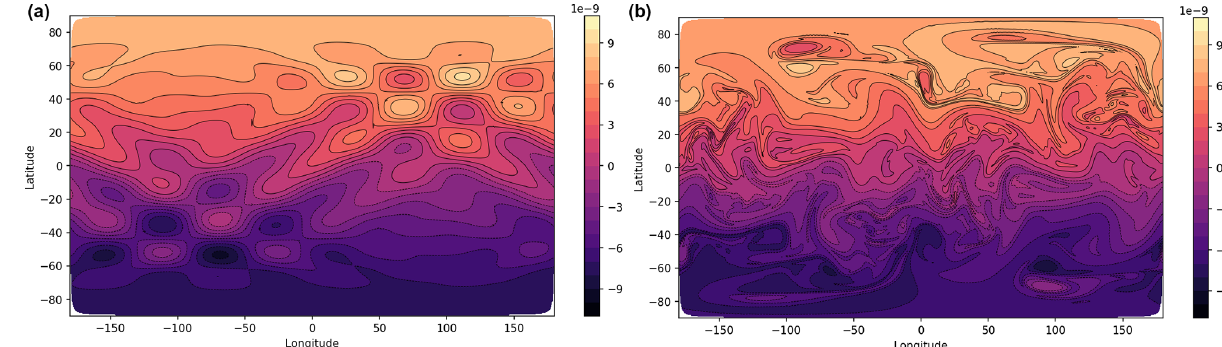
Figure 9. The potential vorticity q for the vortices test case. Panel (a) shows the initial conditions, and panel (b) shows the solution after 15d from a high-resolution C192 simulation.